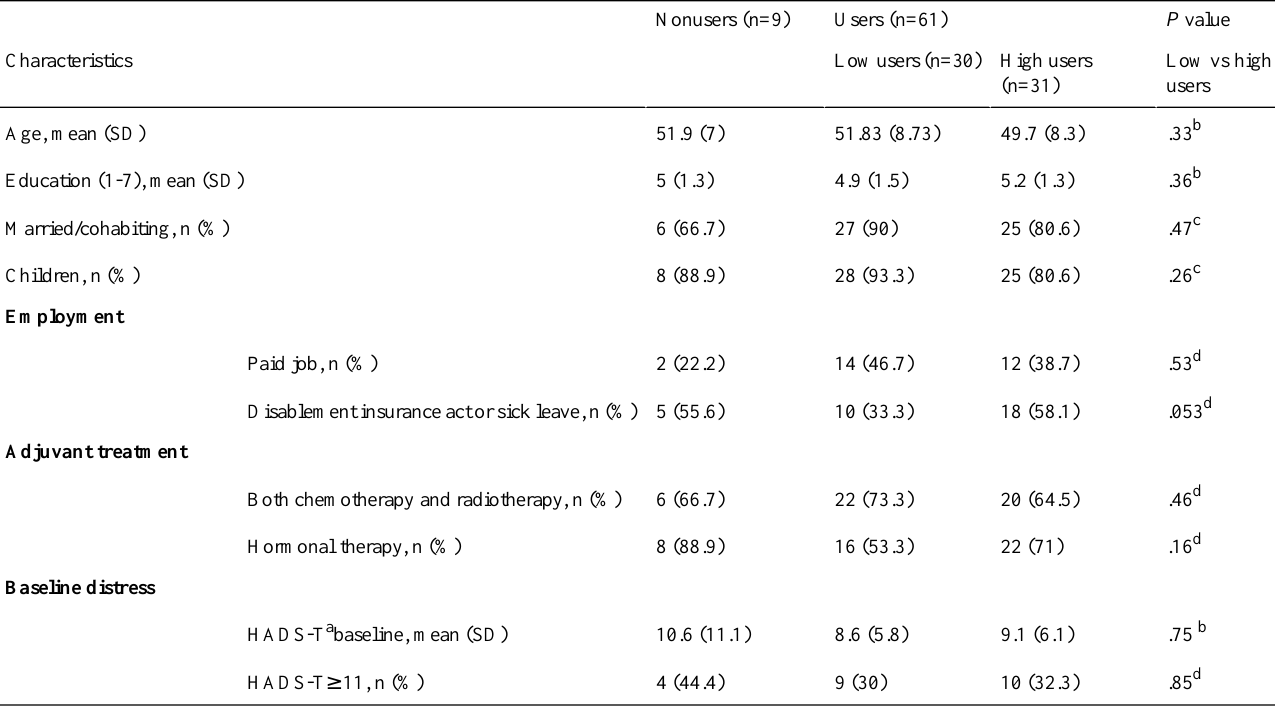
Table 2. Group characteristics (sociodemographic, social, medical) and baseline distress of the three user groups (n=70).